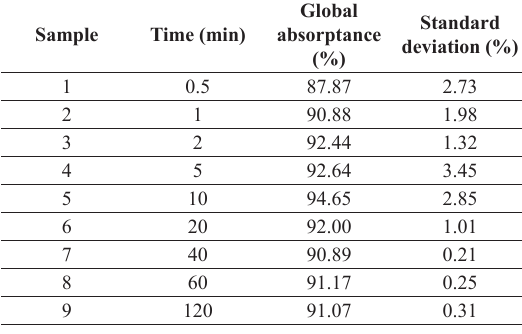
Table 2. Global absorptances of the